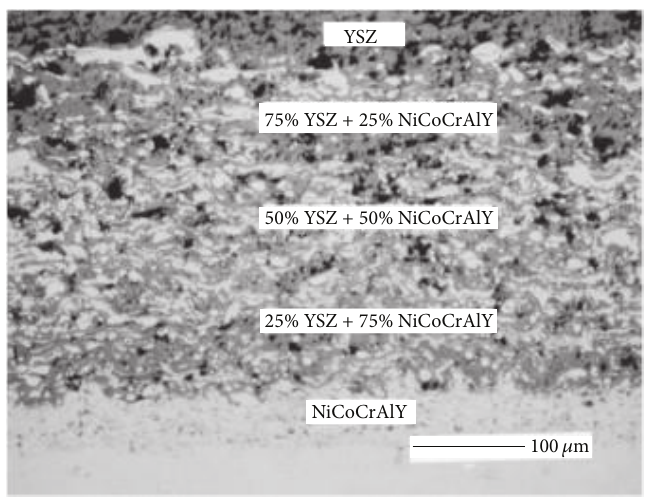
Figure 1: NiCoCrAlY functionally graded material [14].